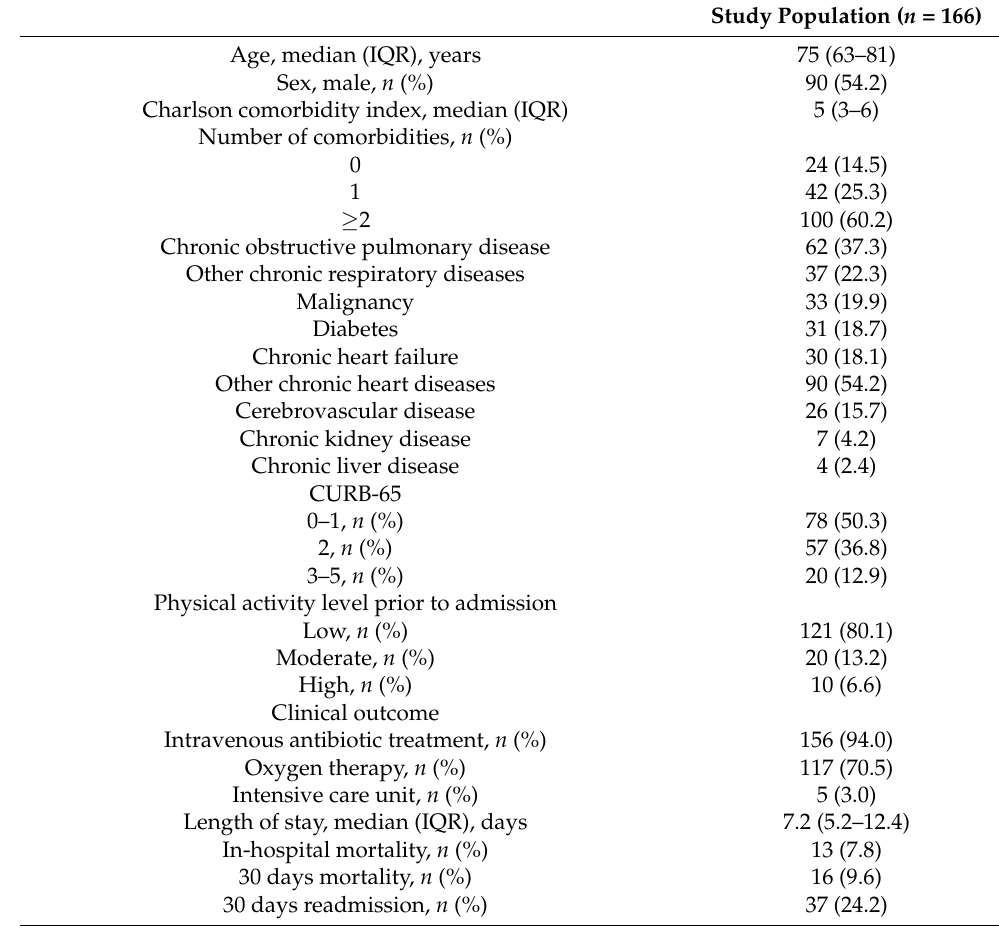
Table 1. Baseline characteristics of 166 patients admitted with community-acquired